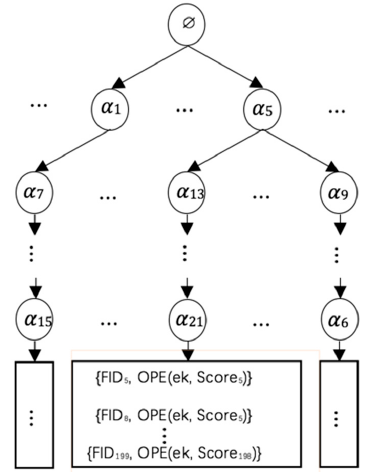
Figure 3. Illustration of the fingerprint index tree.